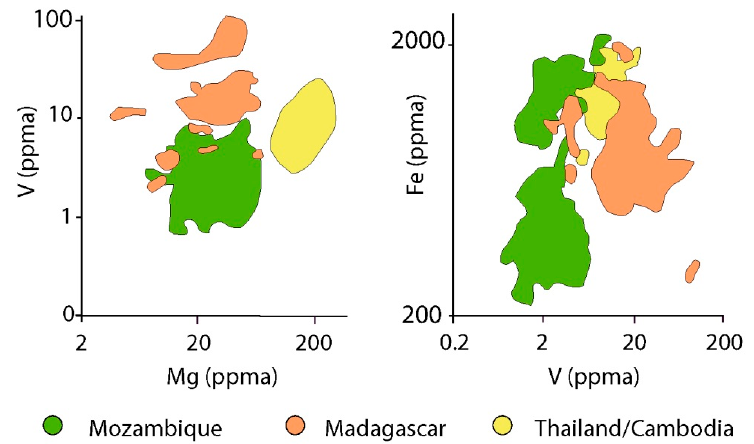
Figure 20. The geographic origin of rubies from Mozambique, Madagascar, and Thailand/Cambodia using V versus Mg and Fe versus V diagrams, modified from [11]. The limits of detection of the analyses by laser ablation-inductively coupled plasma-mass spectroscopy (LA-ICP-MS) are for Mg, V, and Fe respectively, 0.1–0.3, 0.03–0.2, and 5–20 ppm.